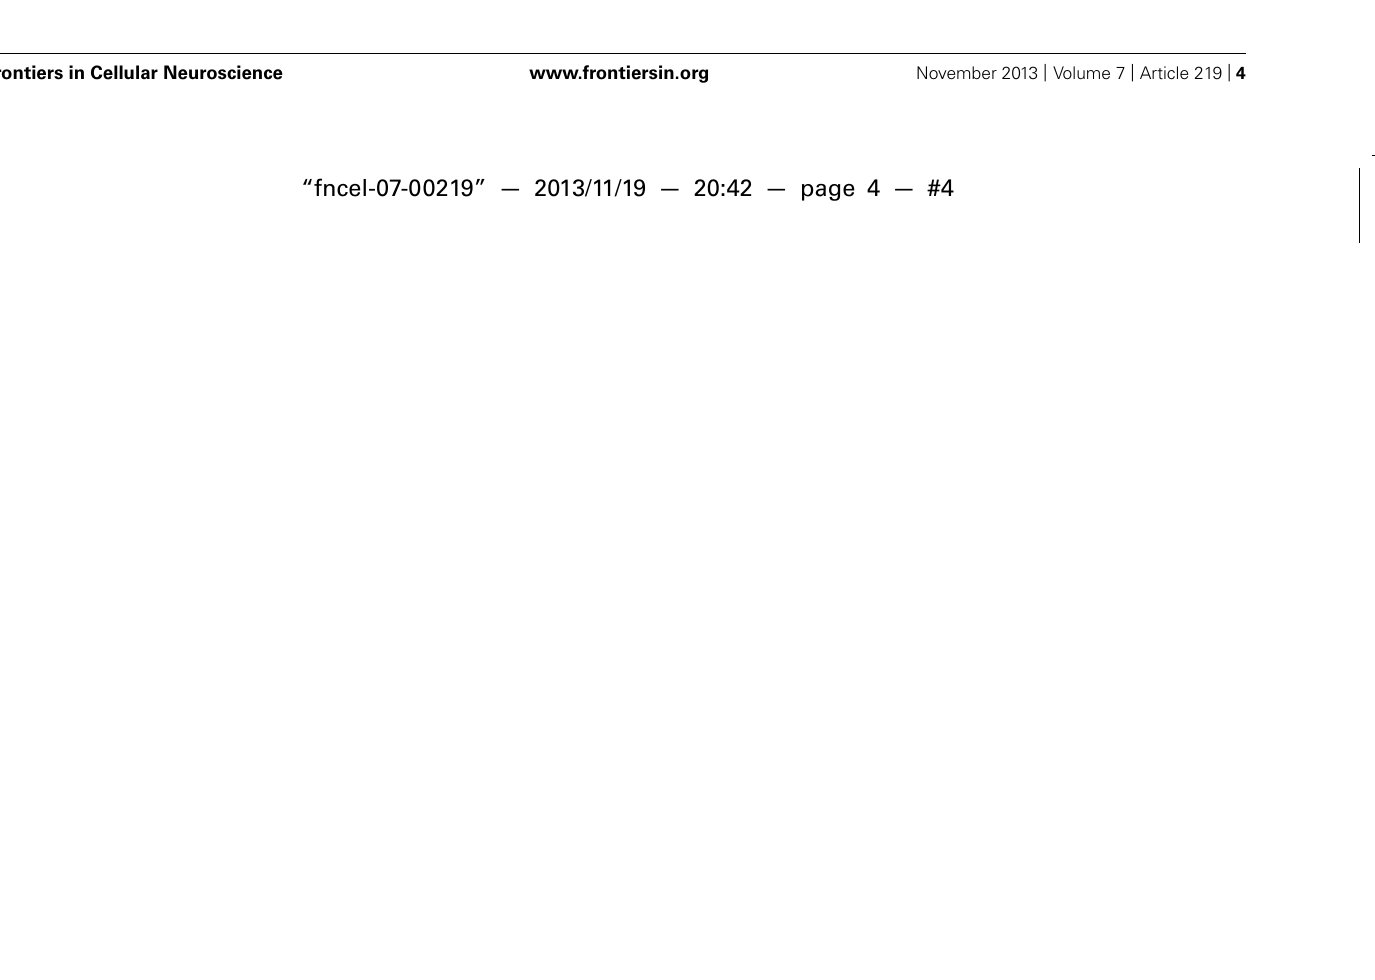
FIGURE 1 | Intrinsic factors: axon-wide increase in synaptic strength or release properties may also affect synapse formation. (A) Schematic drawing of an axon (gray) forming two mature and one nascent bouton on crossing dendrites (brown). We hypothesize that axon-dendrite crossings are marked at potential synaptic locations and contain guidepost adhesion molecules (Shen and Bargmann, 2003; Shen etal., 2004) and weak actin scaffold (Chia etal., 2012). (B) Increasing anchoring of vesicles at presynaptic terminals could decrease the pool